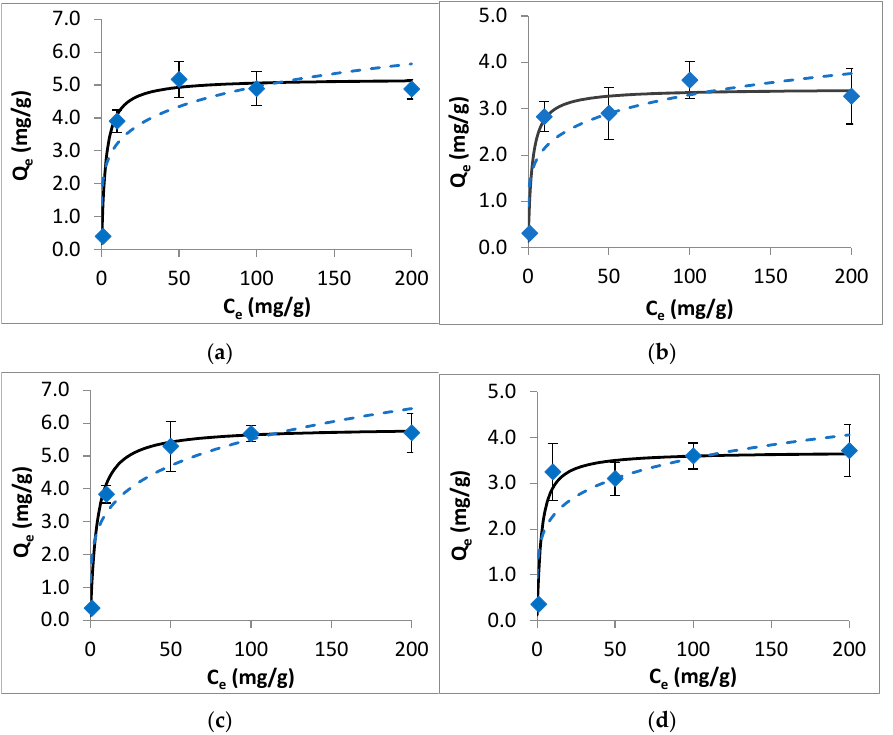
Figure 2. Isotherm data (points), Langmuir model (solid line), and Freundlich model (dashed line) for the adsorption of fluoroquinolones by colemanite. ( a ) Ofloxacin, ( b ) norfloxacin, ( c ) ciprofloxacin, ( d ) enrofloxacin.